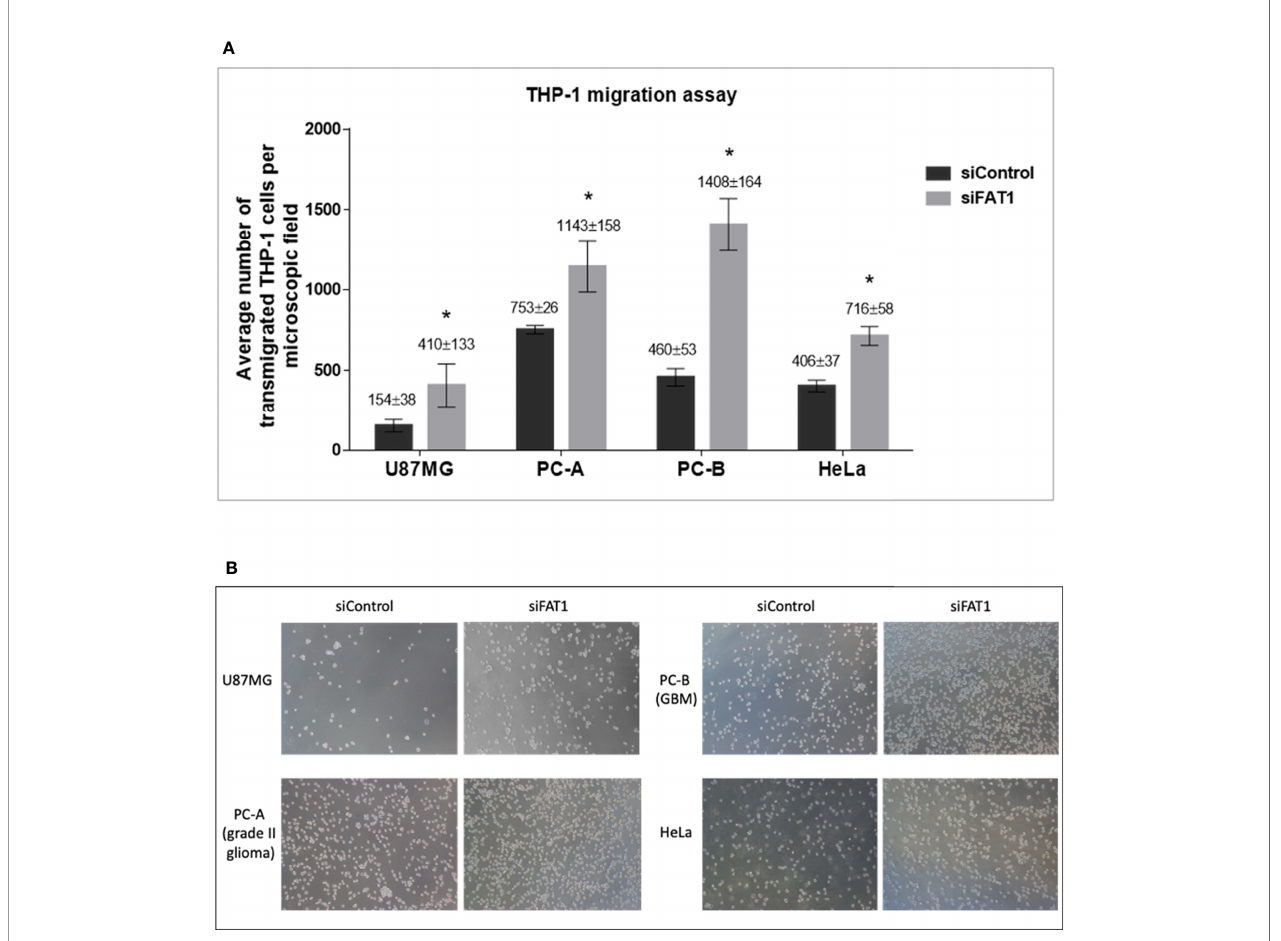
FIGURE 3 | (A) Graphs showing the average number of transmigrated THP-1 cells per microscopic fi eld in response to conditioned medium (culture supernatants) from siControl/siFAT1-transfected U87MG, PC-A, PC-B, and HeLa cells, depicting the modulation of monocyte migration in response to FAT1 knockdown in tumor cells. Transmigrated THP-1 cells have been counted in fi ve non-overlapping microscopic fi elds using ImageJ software, and the number has been presented as average ± SD. Signi fi cance has been indicated by (*) as p-value ≤ 0.01. Experiments were repeated thrice. (B) Microscopic images (10× magni fi cation) of transmigrated THP-1 cells in response to conditioned media (supernatants) from siControl/siFAT1-transfected tumor cells, i.e., U87MG, PC-A, PC-B, and